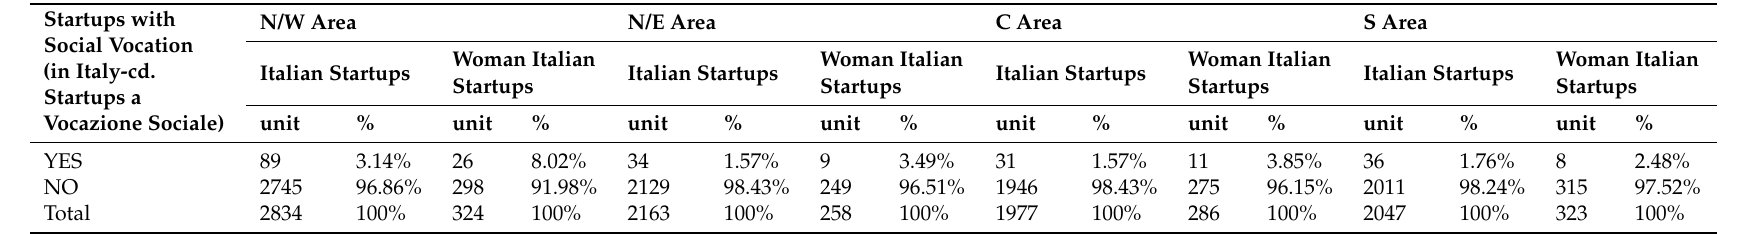
Table 16. Italian startups and Italian woman startups with social vocation for geographical